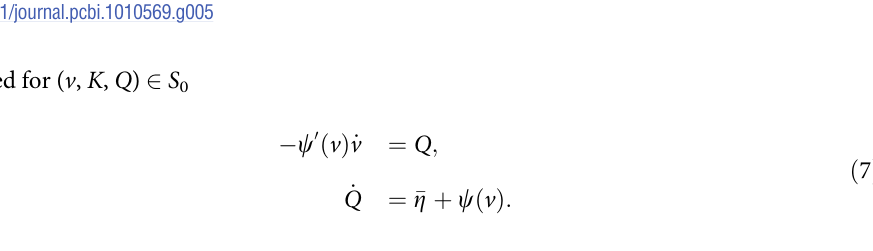
= 100 = − V , A as in Fig 4, t r